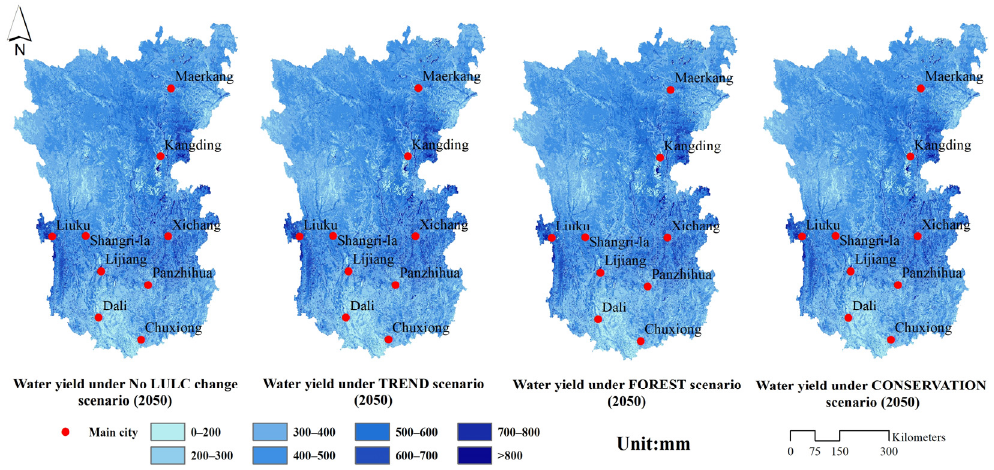
Figure 8. Spatial distribution of water yield under different scenarios (2050).